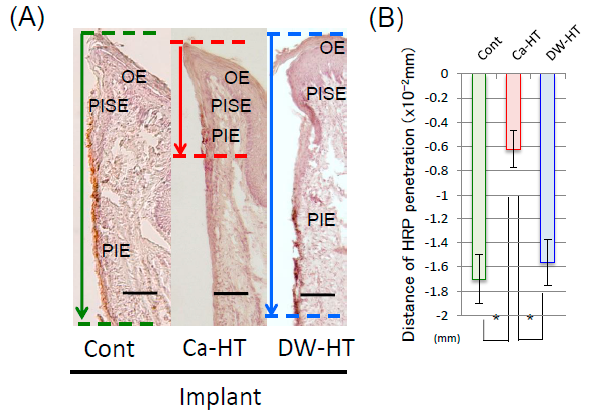
Figure 7. ( A ) Light micrographs of the localization of HRP around the implant. The localization of HRP was restricted in the upper PIE in the Ca-HT group. In other groups, HRP was penetrated more deeply and widely than the Ca-HT group. Bar = 100 µ m. ( B ) Depth of HRP penetration. Each bar represents the mean ± SD. * P < 0.05 vs. Ca-HT.